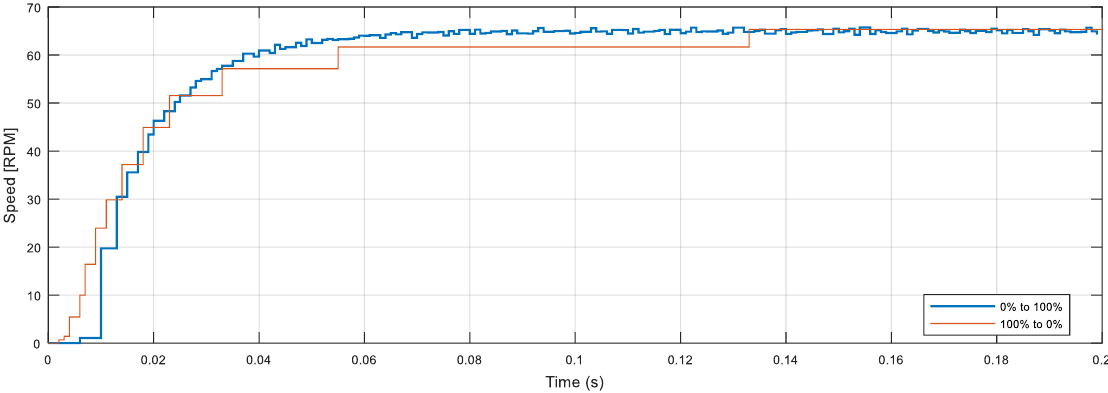
Figure 11. Acceleration curve and inverted deceleration curve moved to t = 0.0 s.